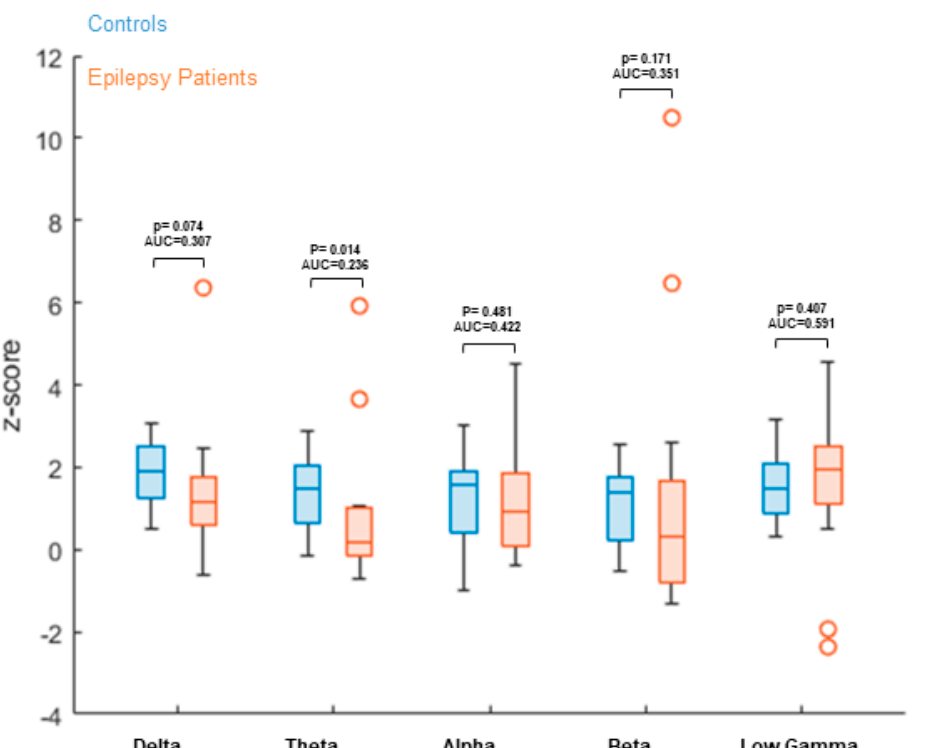
Figure 3. Power comparison between 15 healthy controls and 15 patients with focal epilepsy, comparing EC condition as it complies with our typical patient recording. Results showed no significant difference in ND power levels between patients and controls in alpha, beta and low gamma bands. Significant and close to significant results can be seen in delta and theta bands, with patient ND power lower than controls. Z-values are calculated based on the mean and standard deviation of the control group individually for each parcel. The mean value over all parcels is then calculated and used as the result of the individual subject. These results are then displayed separately per group. Z-values between groups are compared using a non-parametric Wilcoxon rank-sum test, as well as ROC AUC.